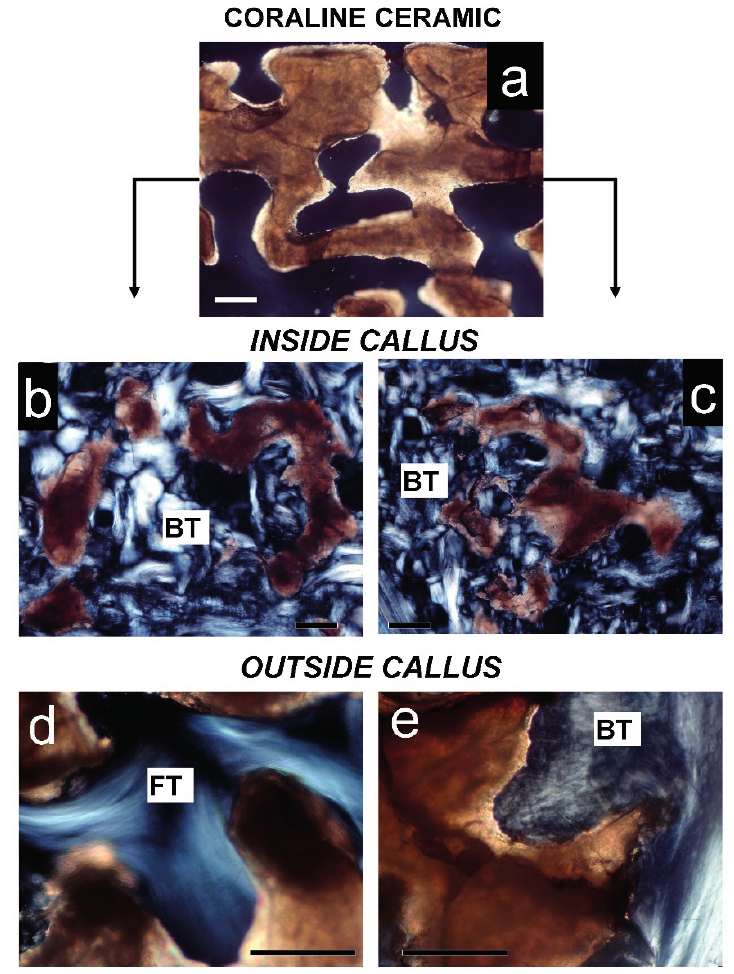
Figure 5. Polarization microscopy of mineral scaffolds. ( a ) Mineral scaffold (Pro Osteon 500) before transplantation; ( b ) Mineral scaffold inside callus in left side (HA group) is partially eroded and completely osteointegrated (BT); ( c ) Mineral scaffold inside callus in right side (HA + MSCs group) is also partially eroded and fully osteointegrated (BT) as bone tissue; ( d ) Mineral scaffold outside callus in left side (HA group) is covered by fibrous tissue (FT); ( e ) Mineral scaffold outside callus in right side (HA + MSCs group) is covered by bone tissue (BT) formed by added cells. Bar = 20